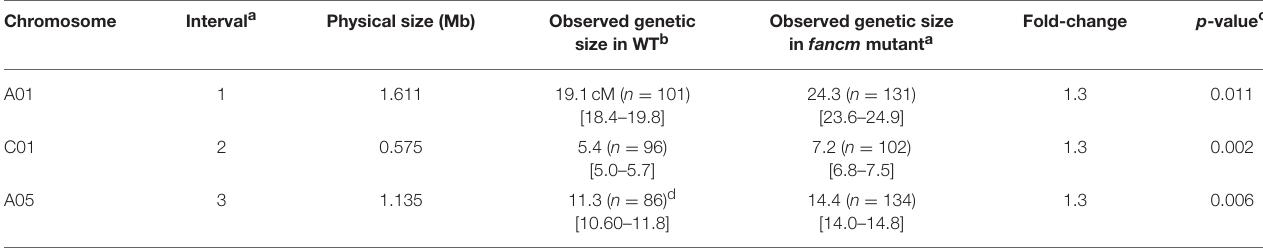
TABLE 1 | Homologous crossover frequencies in homozygous WT and mutant for FANCM in Brassica napus .